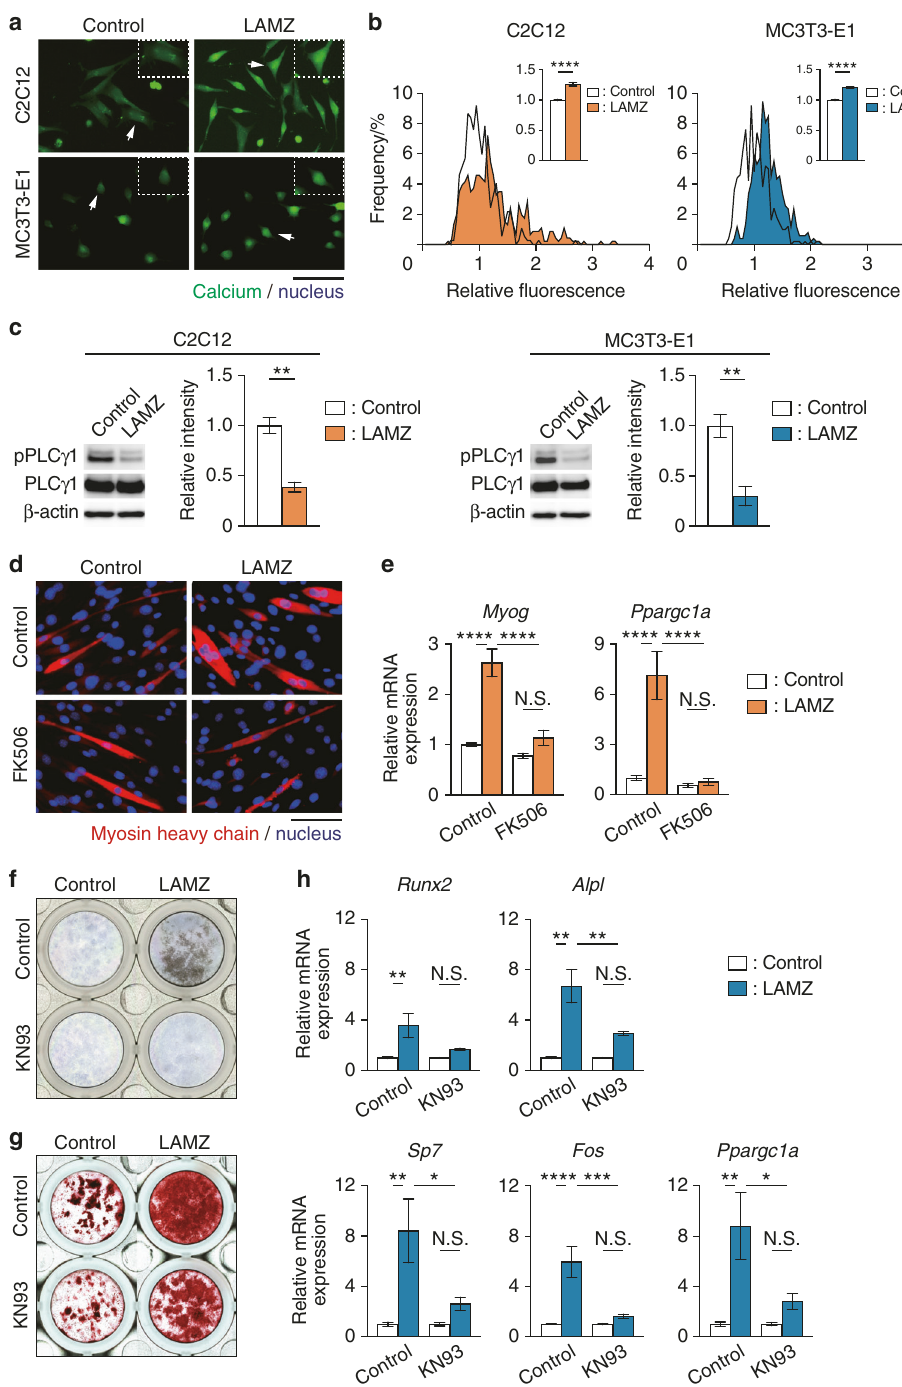
Fig. 4 LAMZ induces calcium signaling to enhance myogenesis and osteoblastogenesis. a Representative images of intracellular calcium in C2C12 cells and MC3T3-E1 cells treated with LAMZ. Calcium (green); nuclei (blue). Scale bar, 50 μ m. b Distribution and mean value (inset) of the fl uorescence intensity that indicates the intracellular calcium. In total, the numbers of cells measured were 369 (control C2C12 cells), 457 (LAMZ-treated C2C12 cells), 499 (control MC3T3-E1 cells) and 507 (LAMZ-treated MC3T3-E1 cells). c Western blotting analysis and subsequent densitometric quantitation of the inhibitory phosphorylation of PLC γ 1 in C2C12 cells and MC3T3-E1 cells. d Representative immunocyto- fl uorescence images of C2C12 cells treated with the calcineurin inhibitor FK506 together with LAMZ. Myosin heavy chain (red); nuclei (blue). Scale bar, 100 μ m. e mRNA expression of Myog and Ppargc1a . f Representative ALP staining images of the MC3T3-E1 cells treated with LAMZ and KN93, an inhibitor of calcium signaling. g Representative Alizarin Red S staining images of MC3T3-E1 cells. h mRNA expression of the osteoblastic genes, Fos and Ppargc1a . Experiments were repeated three times with replicates of 2 or 3 wells. Scale bar, 100 μ m. For the comparison of two groups, statistical analyses were carried out using Student ’ s t test or Welch ’ s t test. For multiple comparisons, two – way ANOVA and Tukey ’ s multiple-comparison test were applied. The error bars show the mean ± s.e.m. * P < 0.05; ** P < 0.01; **** P < 0.000 1; N.S. not signi fi